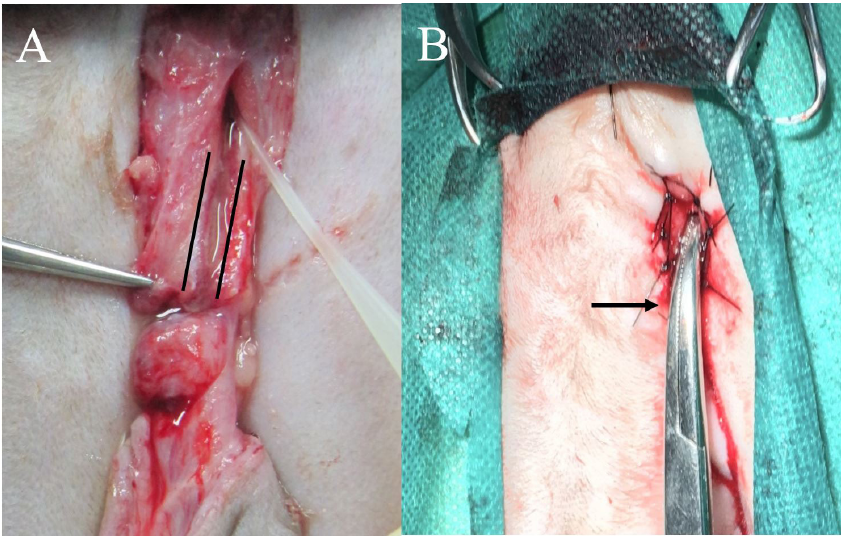
Figure 2. Male feline, 16‑year‑old, Brazilian short‑haired, with foreskin adenocarcinoma. A) Catheterized urethra (rigid probe) after being longitudinally incised and the ischiocavernosus and ischiourethralis muscles sectioned. Note the short gutter generated after penectomy; B) Final image of urethrostomy site. Note that it is possible to enter the urethra with a Crile hemostatic